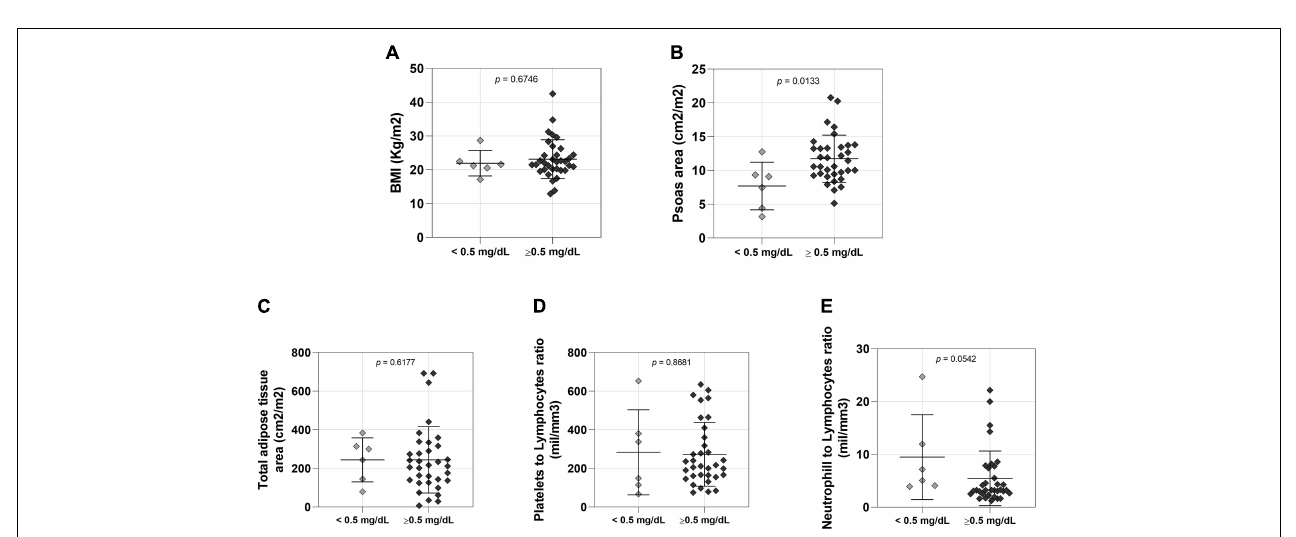
FIGURE 2 | Comparison between lower ( n = 6 < 0.5mg/dL) and normal ( n = 34 > 0.5mg/dL) creatinine level female patients. (A) BMI: body mass index; < 0.5 mg/dL 21.95 ± 3.768 (mean ± SD), > 0.5 mg/dL 23.16 ± 5.749 (mean ± SD); 95% CI –2.430 to 4.510. (B) Psoas area; < 0.5 mg/dL 7.704 ± 3.517 (mean ± SD), > 0.5 mg/dL 11.73 ± 3.496 (mean ± SD); 95% CI 0.8896 to 7.163. (C) Total adipose tissue; < 0.5 mg/dL 244.2 ± 113.8 (mean ± SD), > 0.5 mg/dL 244.4 ± 171.8 (mean ± SD); 95% CI –141.8 to 97.40. (D) Platelets to lymphocytes ratio; < 0.5 mg/dL 283.5 ± 220.2 (mean ± SD), > 0.5 mg/dL 272.6 ± 165.1 (mean ± SD); 95% CI –181.3 to 144.8. (E) Neutrophill to lymphocytes ratio; < 0.5 mg/dL 9.480 ± 8.036 (mean ± SD), > 0.5 mg/dL 5.470 ± 5.174 (mean ± SD); 95% CI –8.700 to 0.0800.